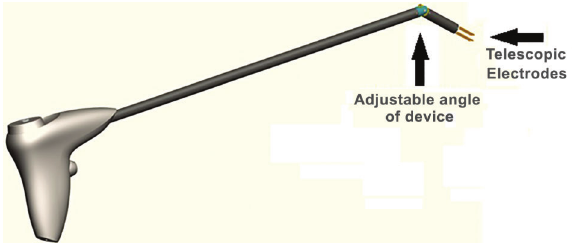
Figure 1. LARA-K1. Functional prototype with angled end in the long axis.